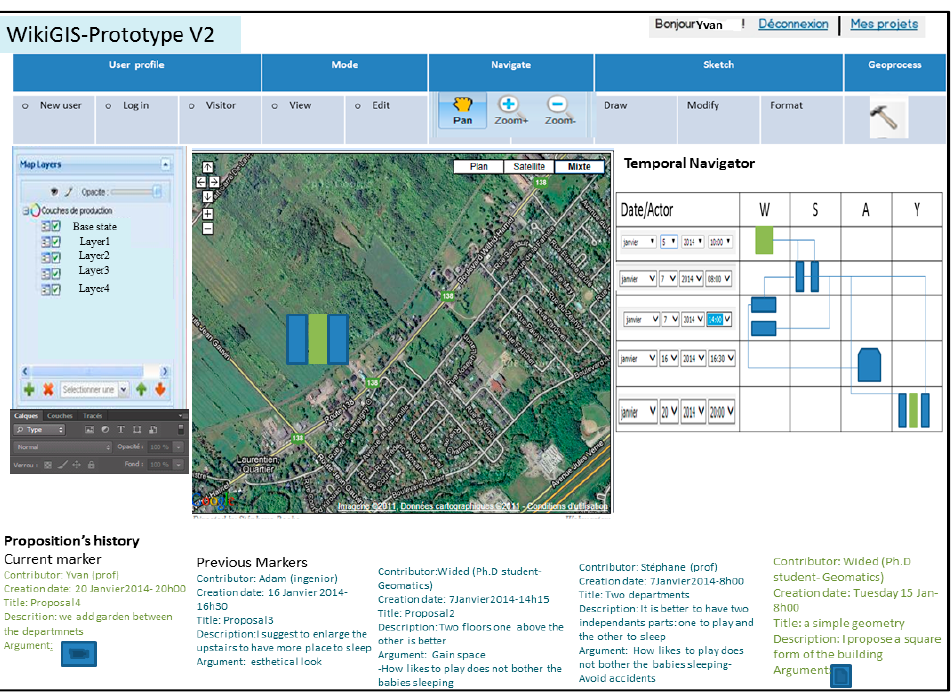
Figure 26. Fifth proposal in the